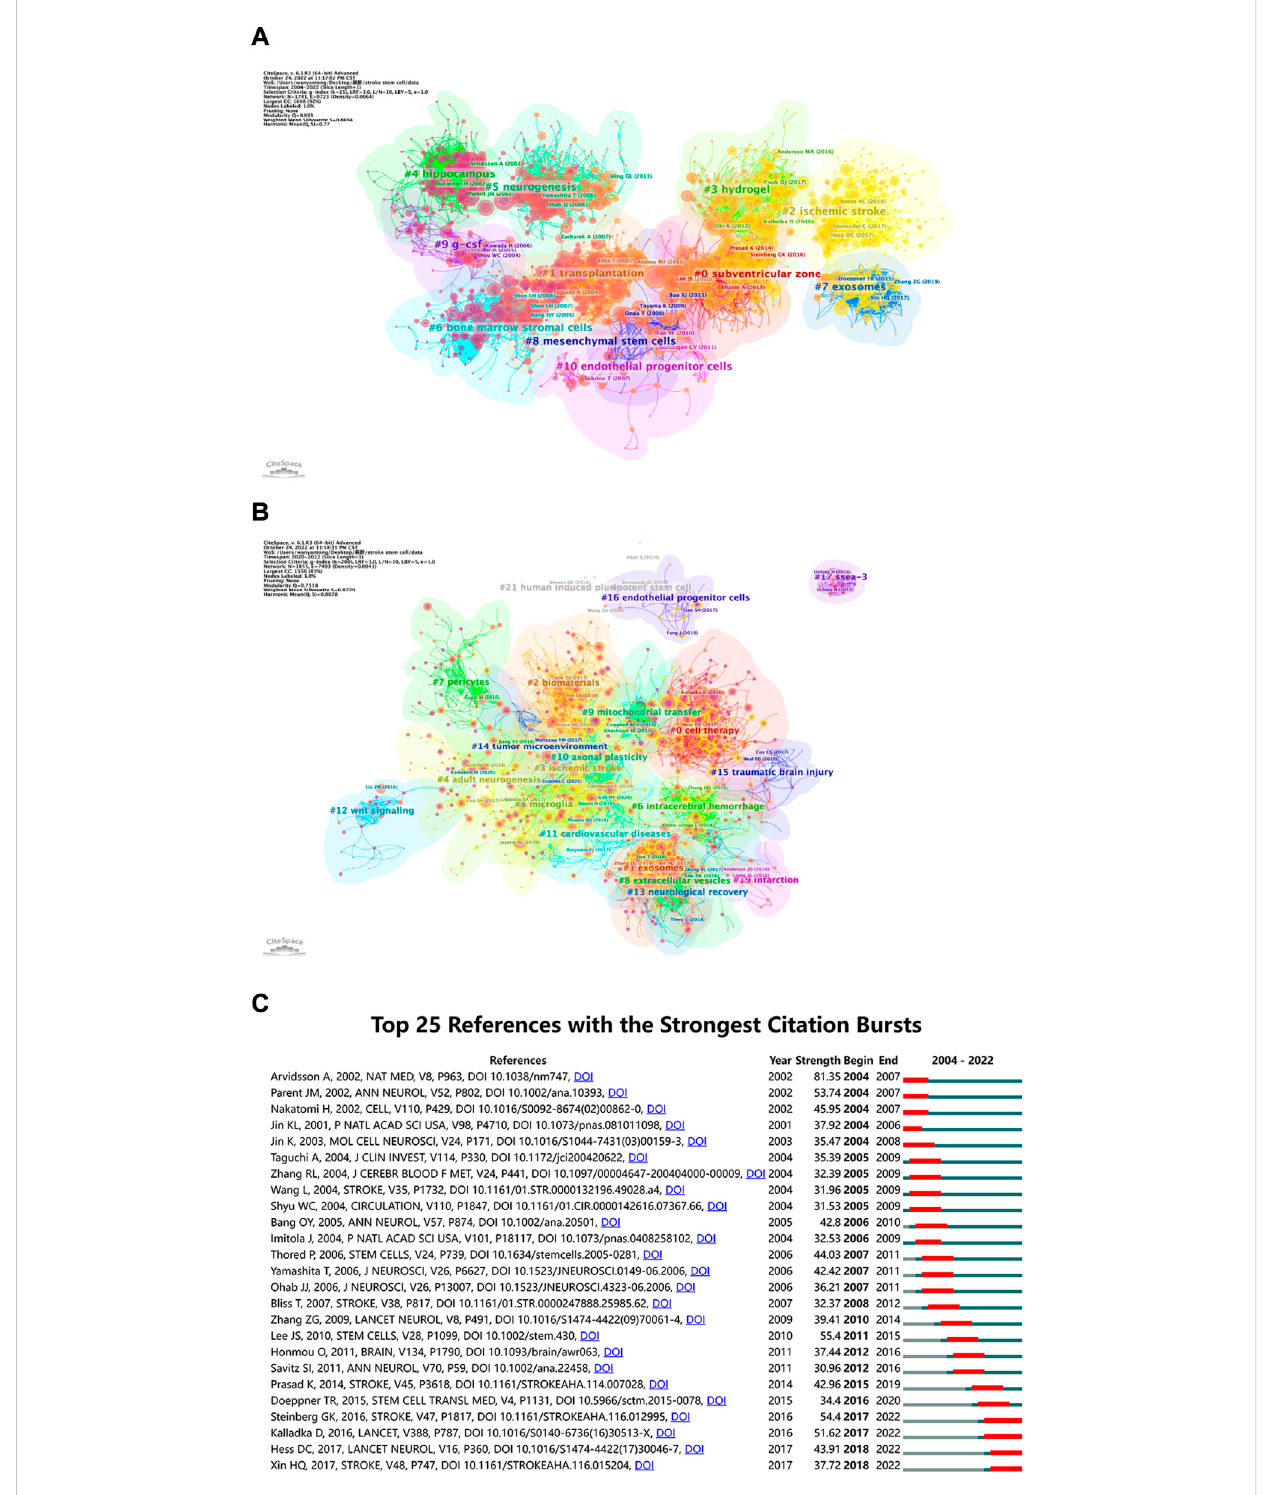
FIGURE 7 (A) Co-cited references related to stem cells in stroke. The circles represent the number of co-citations, the purple circle represents centrality, the thickness of connection indicates the cooperation degree, and thepurple to yellow gradient represents the time from the past to the present. (B) Cluster view of references in stem cells in stroke research in recent 3 years. The larger the circle, the more times the corresponding paper has been cited in the last 3 years (C) CiteSpace visualization map of top 25 references with the strongest citation bursts involved in stem cells in stroke. The blue line represents the time interval. The blue line represents the time interval. The time in which a reference was found to have a burst is displayed by a red line, indicating the fi rst year and the last year of the duration of the